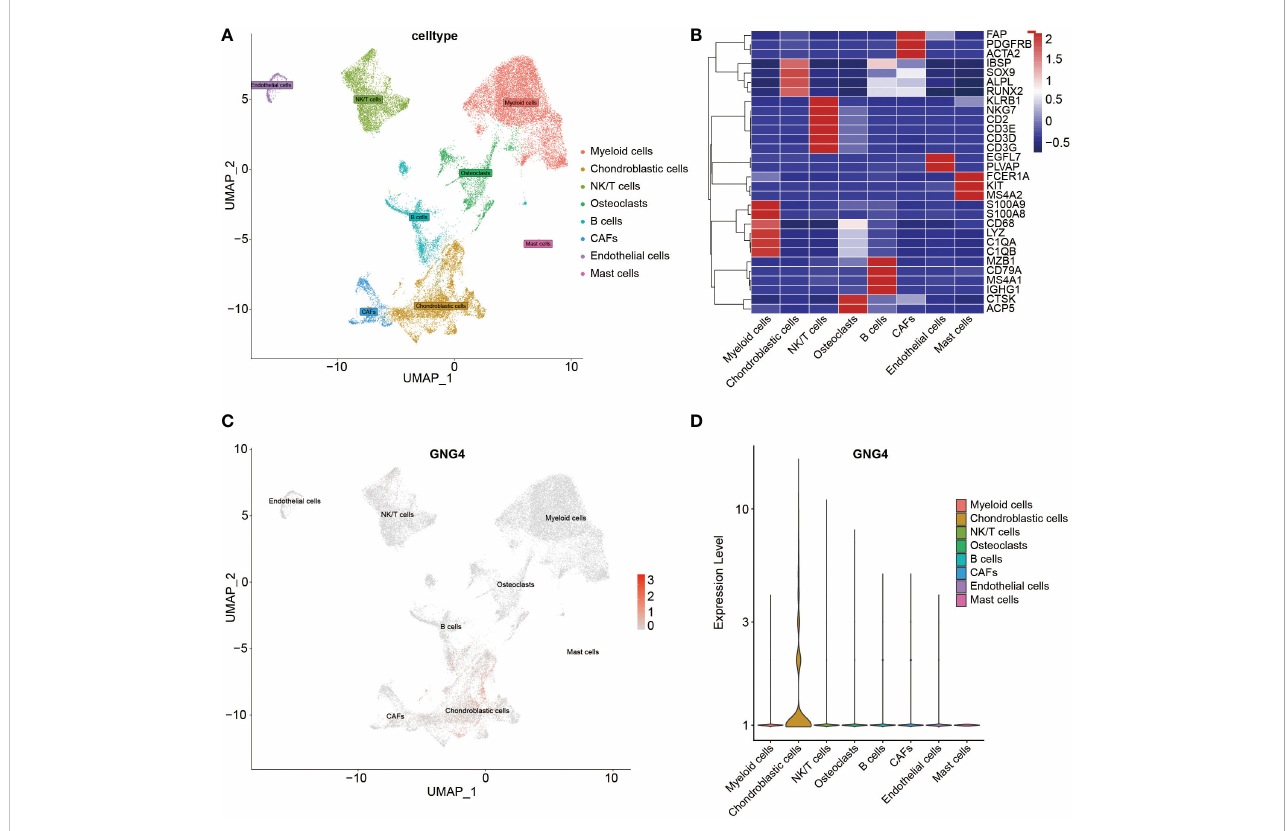
(Figure 3E). In conclusion, this nomogram may be a better model than a single prognostic factor for predicting survival in patients with